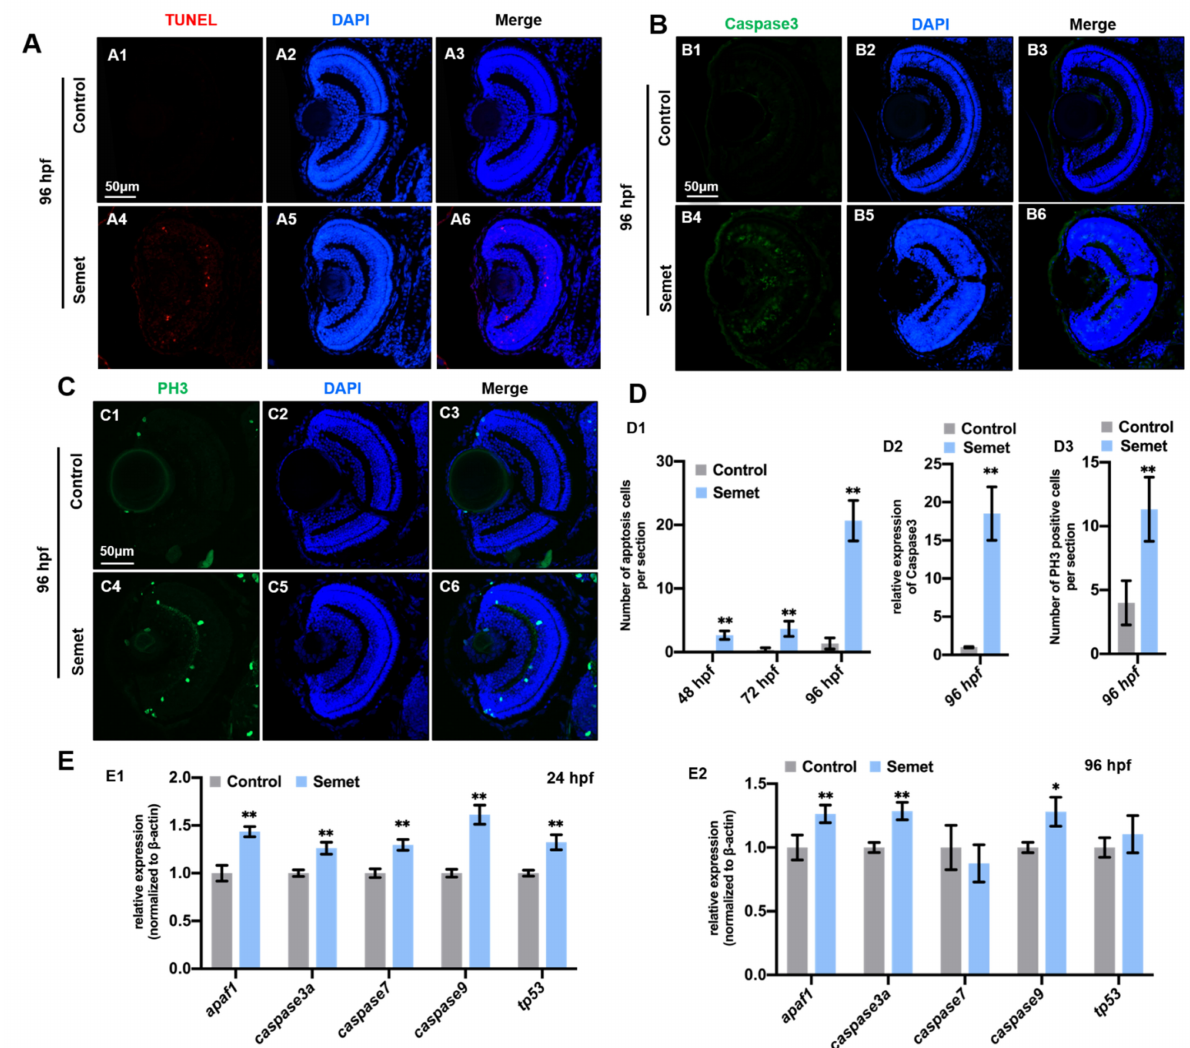
Figure 3. Cell apoptosis and proliferation in selenium-treated embryos. ( A ) Cell apoptosis assay by TUNEL (red dots) detection in section of control ( A1 – A3 ) and selenium-treated ( A4 – A6 ) embryos at 96 hpf. ( B ) Immunostaining of Caspase3 in section of control ( B1 – B3 ) and selenium-treated ( B4 – B6 ) embryos at 96 hpf. ( C ) Cell proliferation assay by PH3 staining (green dots) in section of control ( C1 – C3 ) and selenium-treated ( C4 – C6 ) embryos at 96 hpf. ( D ) Number of apoptosis cells ( D1 ), relative expression of caspase3 ( D2 ) and number of PH3 positive cells ( D3 ). ( E ) Expression of apoptosis marker genes in control and selenium-treated embryos at 24 hpf ( E1 ) and 96 hpf ( E2 ). **, P < 0.01; *, P <